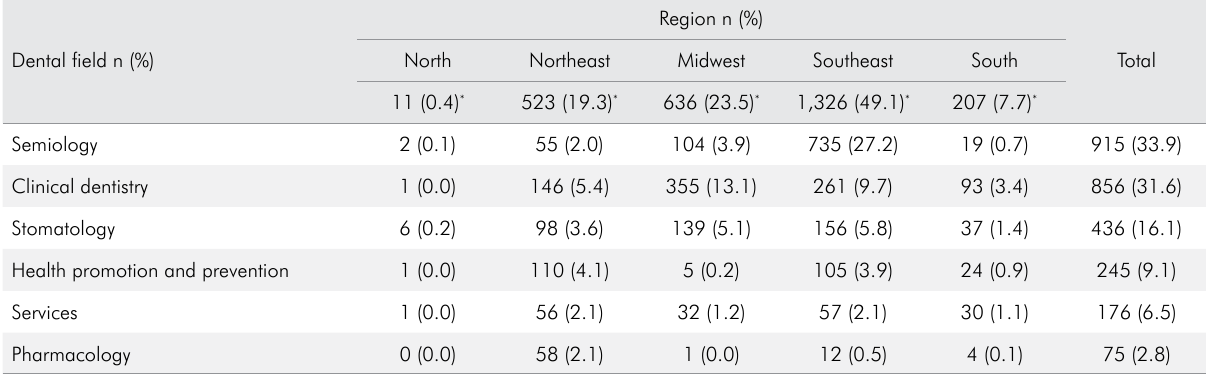
Table 3. Descriptive analysis of dental teleconsulting by field of issue per region. Brazil, 2019.